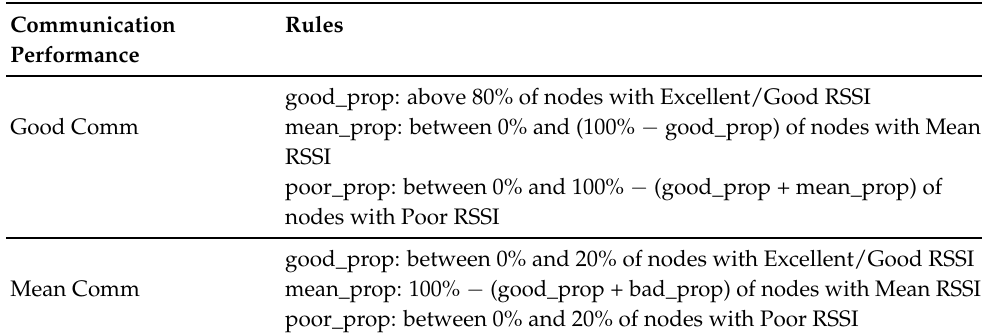
Table 4. Communication cluster-level features.